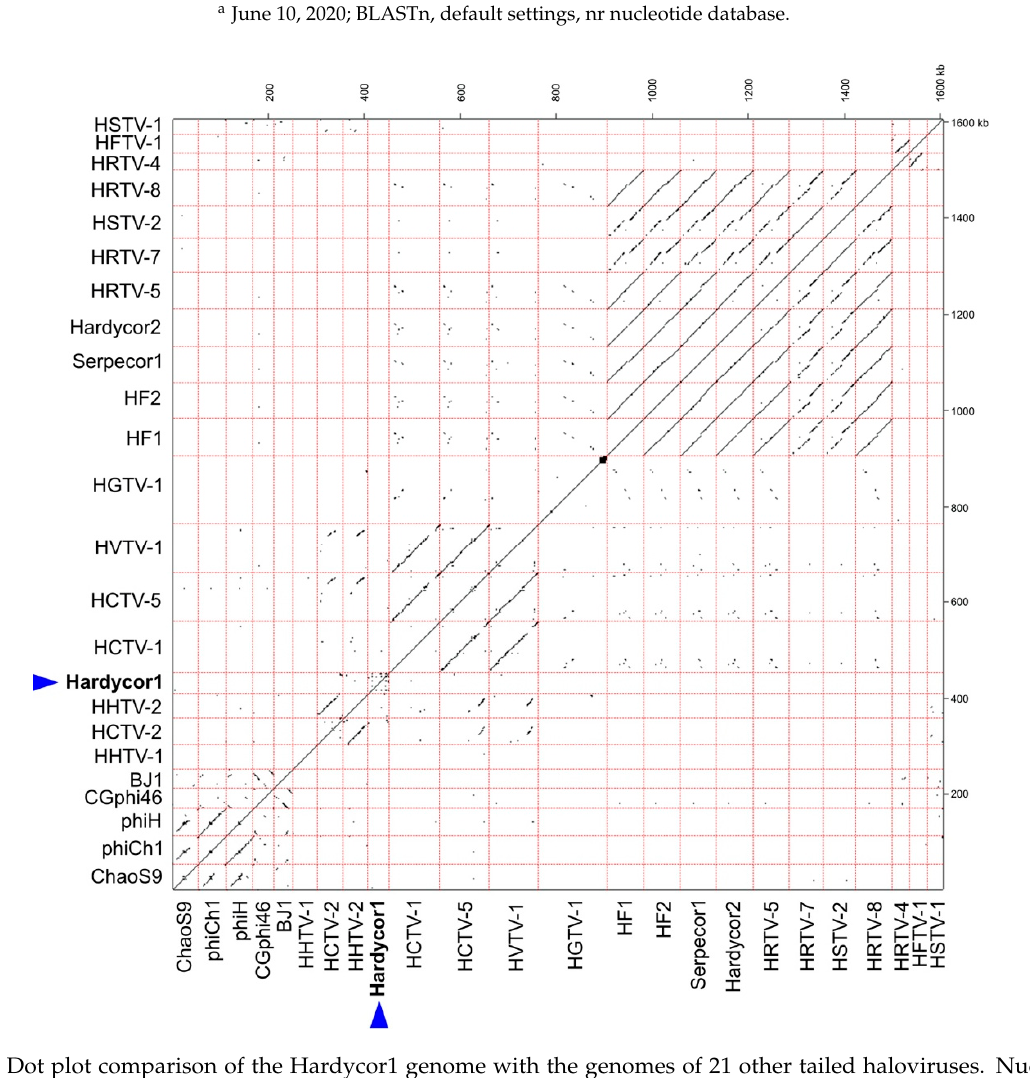
Table 4. BLASTn matches to the Hardycor1 genome a.